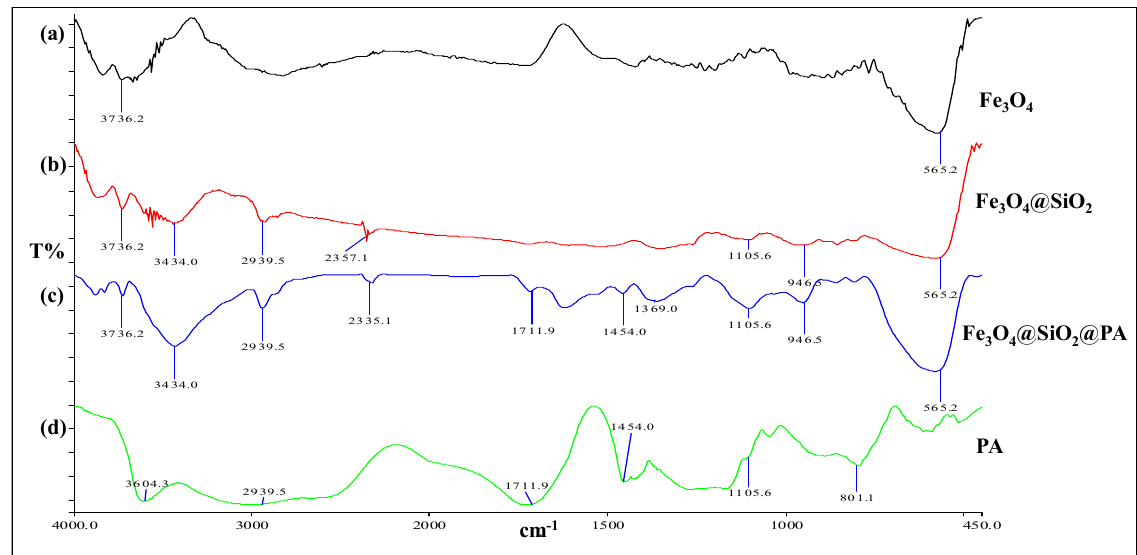
Figure 1. FTIR spectra of ( a ) Fe 3 O 4 magnetic nanoparticle, ( b ) Fe 3 O 4 @SiO 2 , ( c ) Fe 3 O 4 @SiO 2 @PA, and ( d ) polyacrylic acid (PA).